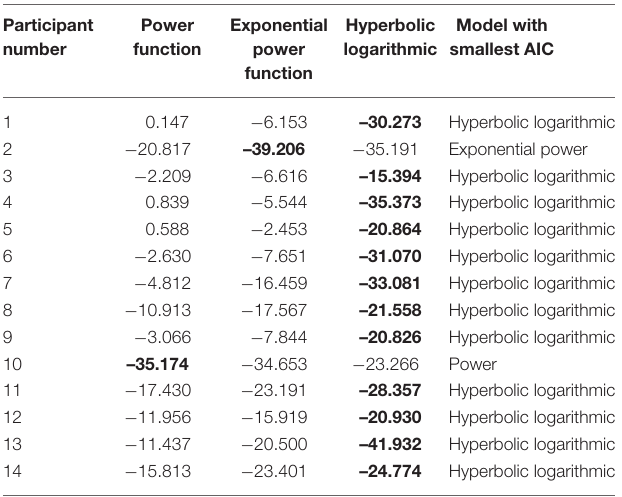
TABLE 9 | Models’ AICs and the model with the smallest AIC by participant.